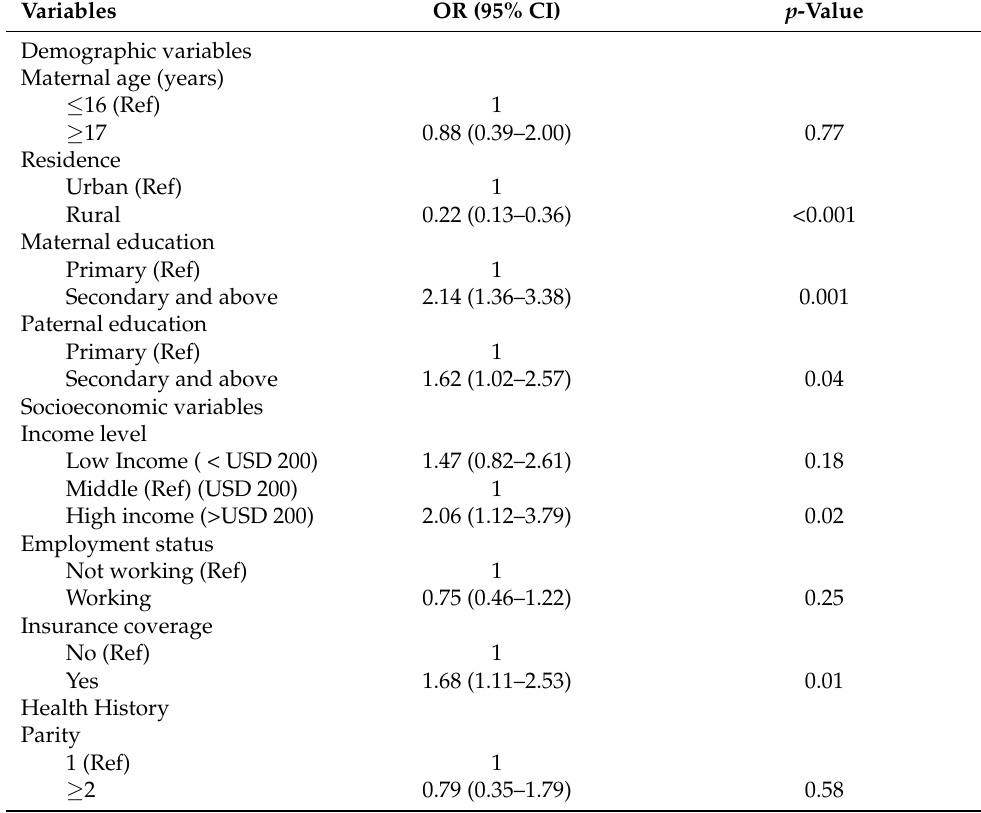
Table 3. Independent variables with relation to place of